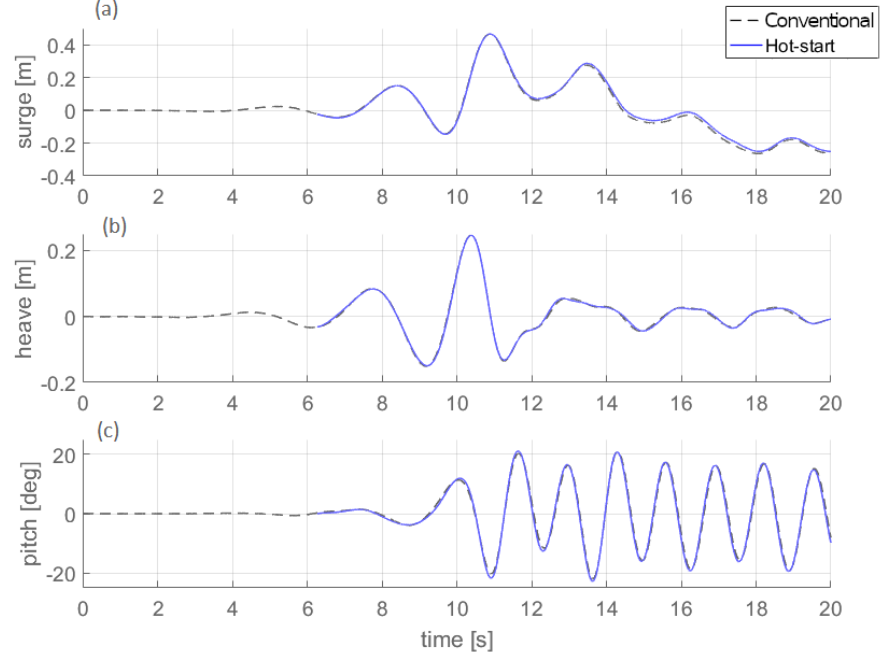
Figure 13. CFD motion responses time-series when conventionally started and when hot-started at focus (Hot-started with t minus = 4s and 5 time-steps for RBM